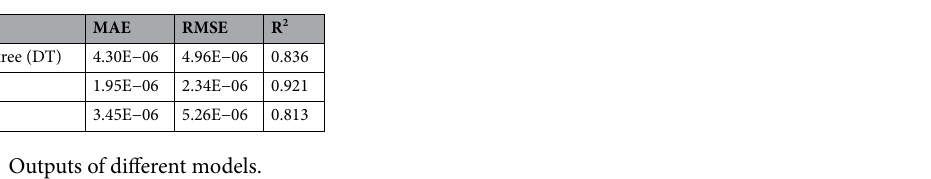
Table 2. Outputs of different